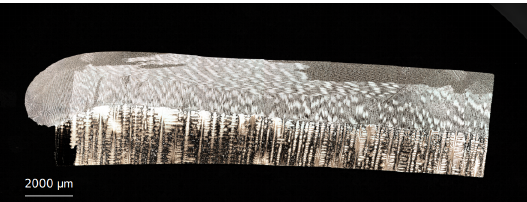
Figure 5. Longitudinal cross section of a CMSX-4 (cid:114) specimen fabricated with 750 W laser power and scan speed of 600 mm/s showing increase in melt pool depth along the length of the specimen (Reproduced with permission from the authors of